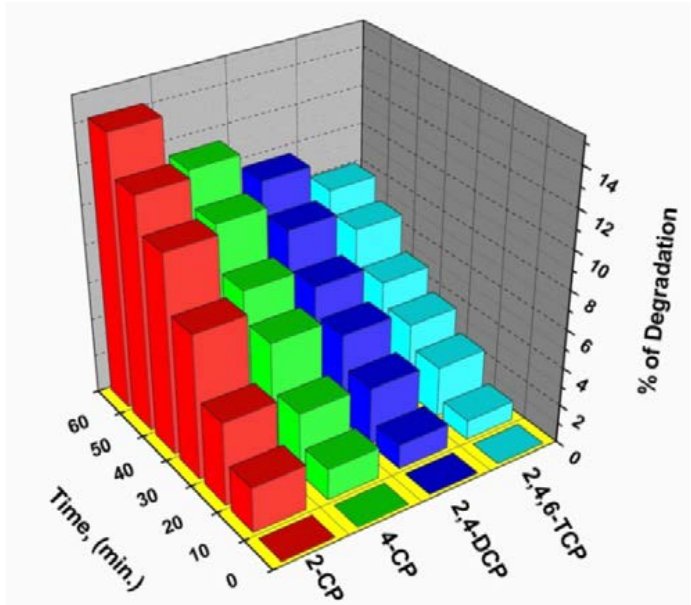
Fig. 9: The photocatalytic degradation efficiencies of 2-CP, 4-CP, 2,4-DCP and 2,4,6- TCP in the absence of Ir-doped TiO NPs under sunlight 2